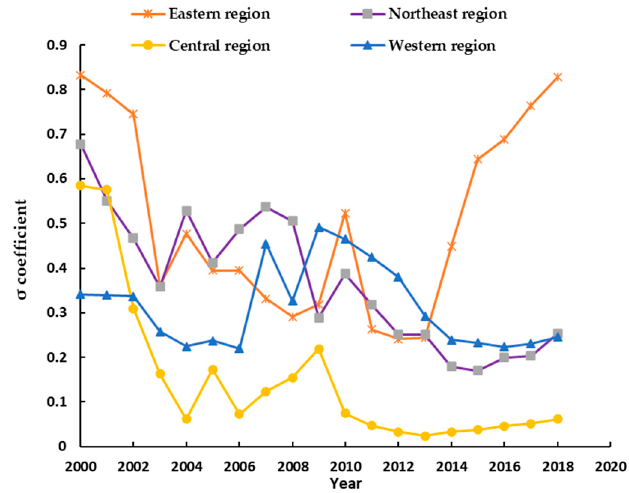
Figure 4. The σ - convergence change trend of the virtual cultivated land flow intensity in four major Figure 4. The σ -convergence change trend of the virtual cultivated land flow intensity in four regions. major regions.